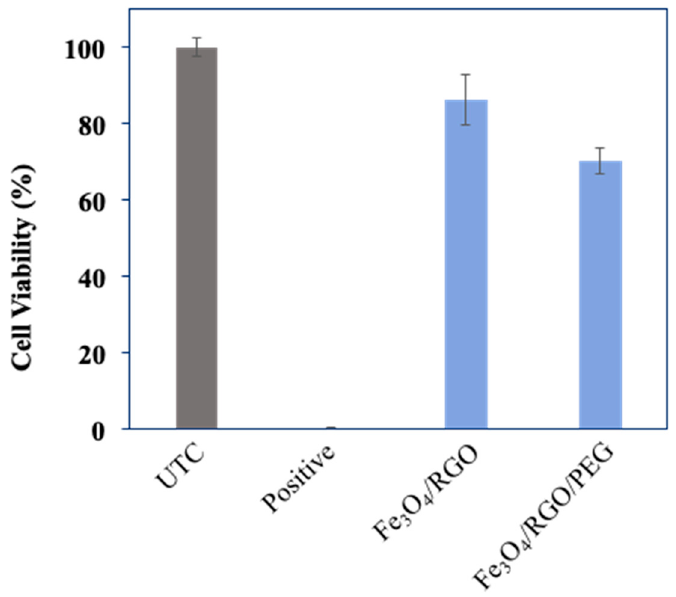
Figure 8. Cytotoxicity analysis of Fe 3 O 4 nanocomposites in MCF-7 cells (24 h incubation).